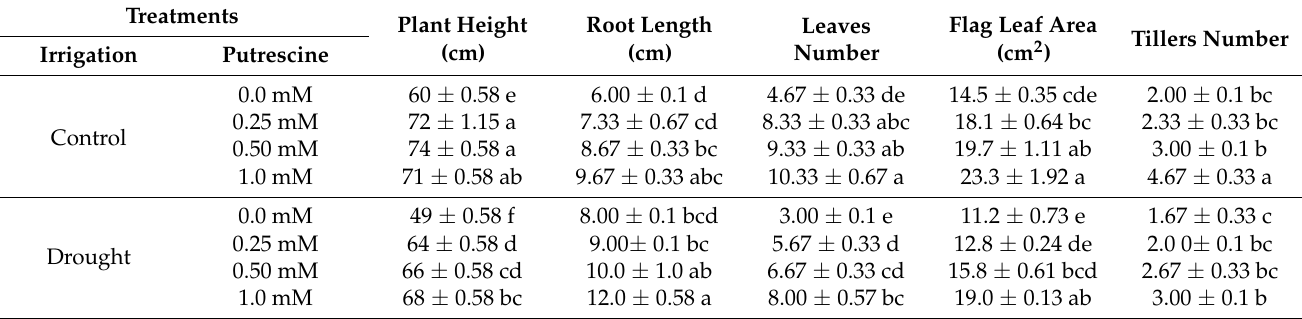
Table 1. The response of some growth characteristics of wheat plants to putrescine, drought stress, and their combination. Values depict the mean and standard error. Different letters indicate significance between